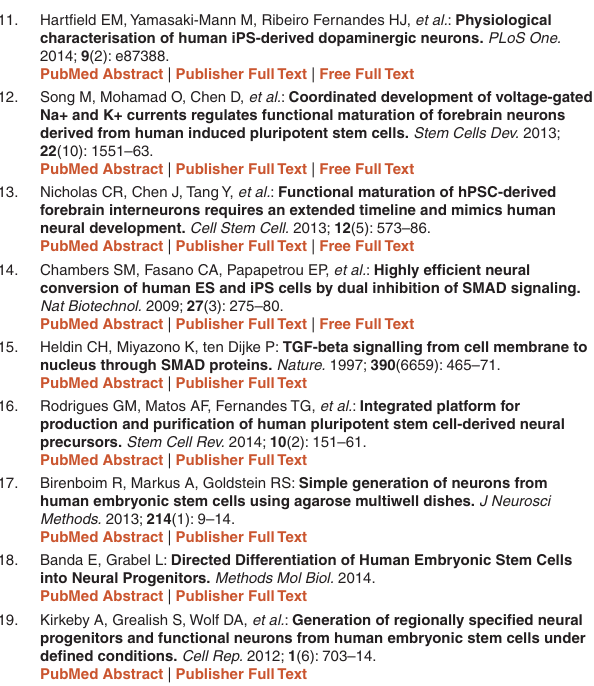
11. Hartfield EM, Yamasaki-Mann M, Ribeiro Fernandes HJ, et al. : Physiological characterisation of human iPS-derived dopaminergic neurons. PLoS One. 2014; 9 (2): e87388. PubMed Abstract | Publisher Full Text | Free Full Text 12. Song M, Mohamad O, Chen D, et al. : Coordinated development of voltage-gated Na+ and K+ currents regulates functional maturation of forebrain neurons derived from human induced pluripotent stem cells. Stem Cells Dev. 2013; 22 (10): 1551–63.